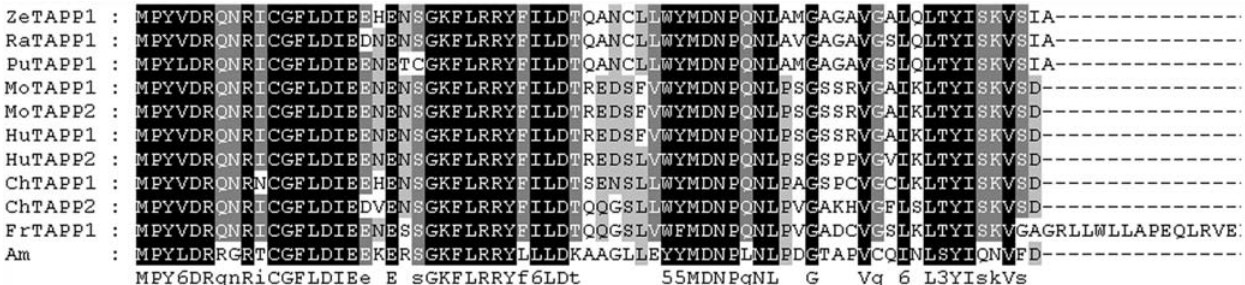
Figure 8. Amino acid sequence alignment TAPP1 and TAPP2. Hu=human, Mo= mouse, Ch=chicken, Am=amphioxus, Fr=frog, Ze=zebrafish, Ra=rat, Pu=Pufferfish. NCBI accession numbers: Q9HB21, human TAPP1; AF286164, human TAPP2; Q8BUL6, mouse TAPP1; Q9ERS5, mouse TAPP2; XP_421799, chicken TAPP1; NP_990029, chicken TAPP2; AAH76776, frog TAPP1; AAH44452, zebrafish TAPP1; XP_341943, rat TAPP1; CAG10059, Pufferfish TAPP1.